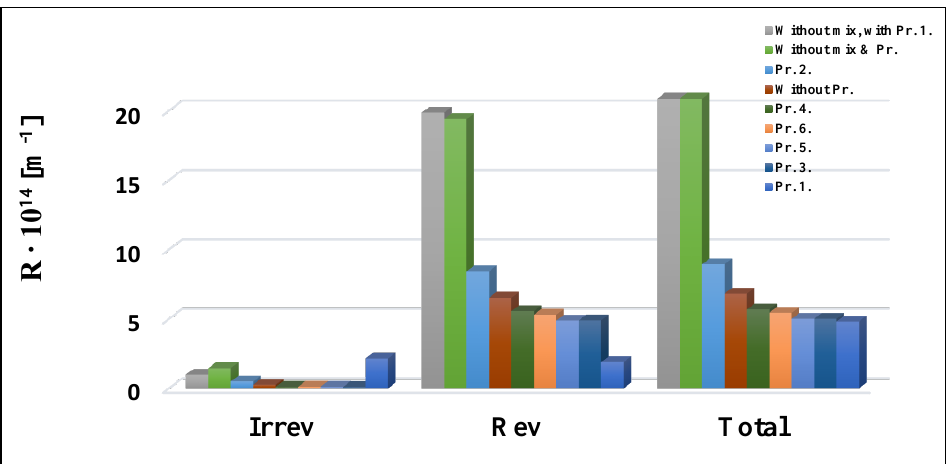
Figure 9. Effects of turbulence promoter types at 400 rpm mixing on the resistance values of a 150 kDa NMWL UF membrane.